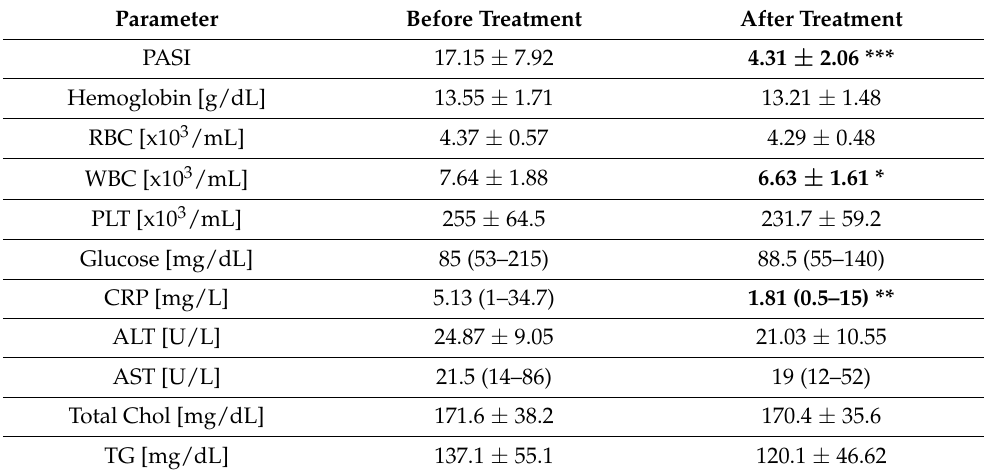
before treatment with p < 0.05; <0.01; <0.001, respectively.